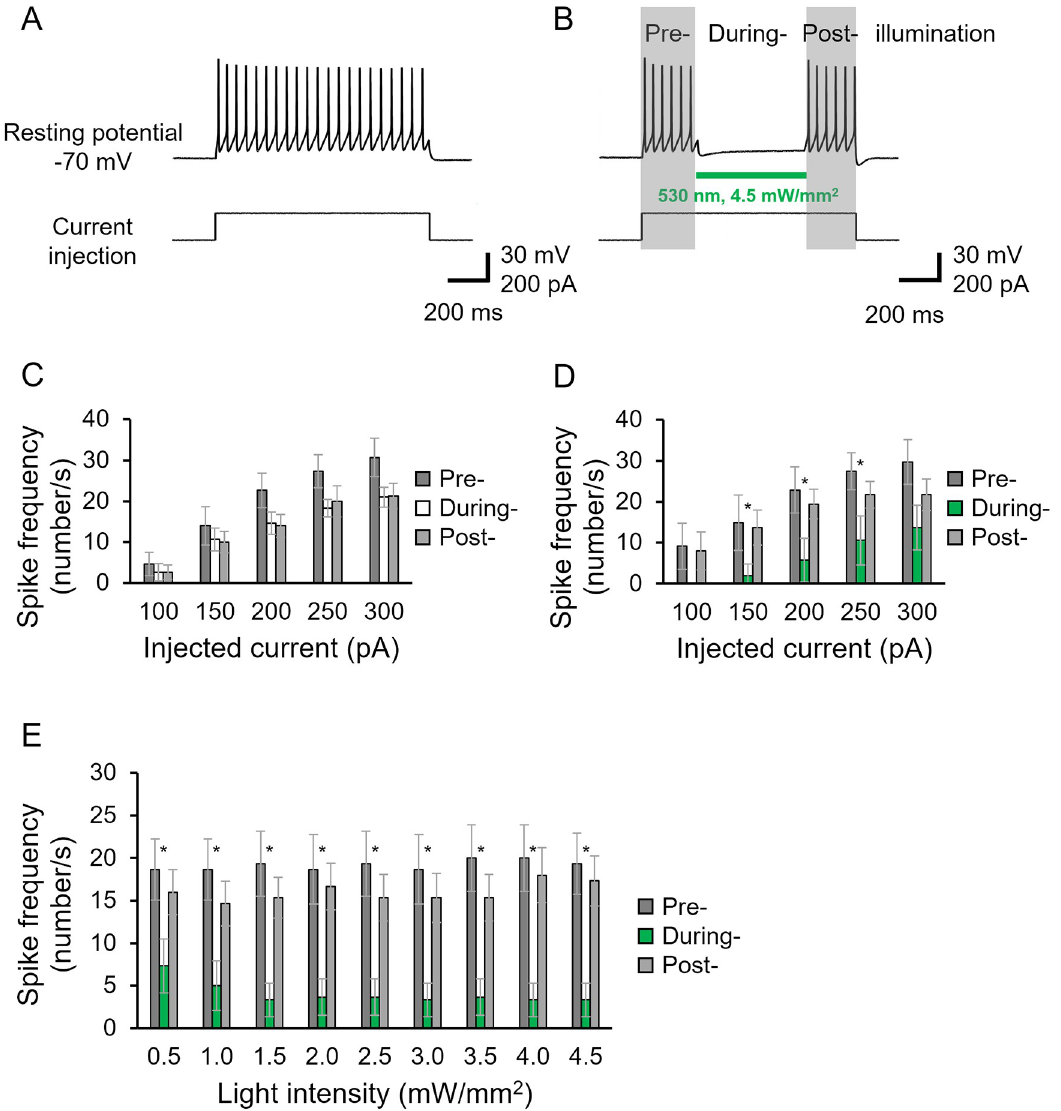
Fig 6. Neuronal silencing by KR2. A, Representative traces of action potentials by current injection (200 pA) as shown below the trace in a KR2-expressing cultured neuron. Solutions used were listed in Table. B, Evoked spikes were suppressed by green light illumination as indicated by a green bar in a KR2-expressing neuron. C and D, Spike frequency at various injected currents are compared in KR2-expressing neurons. Number of spikes in darkness (Pre-illumination), upon illumination (During-illumination) and again in darkness (Post-illumination) are indicated. C, no illumination in “During” shown by white bars. D, illumination in “During” shown by green bars. n = 6, 7. E, light power dependency on neuronal silencing (n = 6). Spike frequency is shown at various light intensities. The neuron was excited by 150 pA current